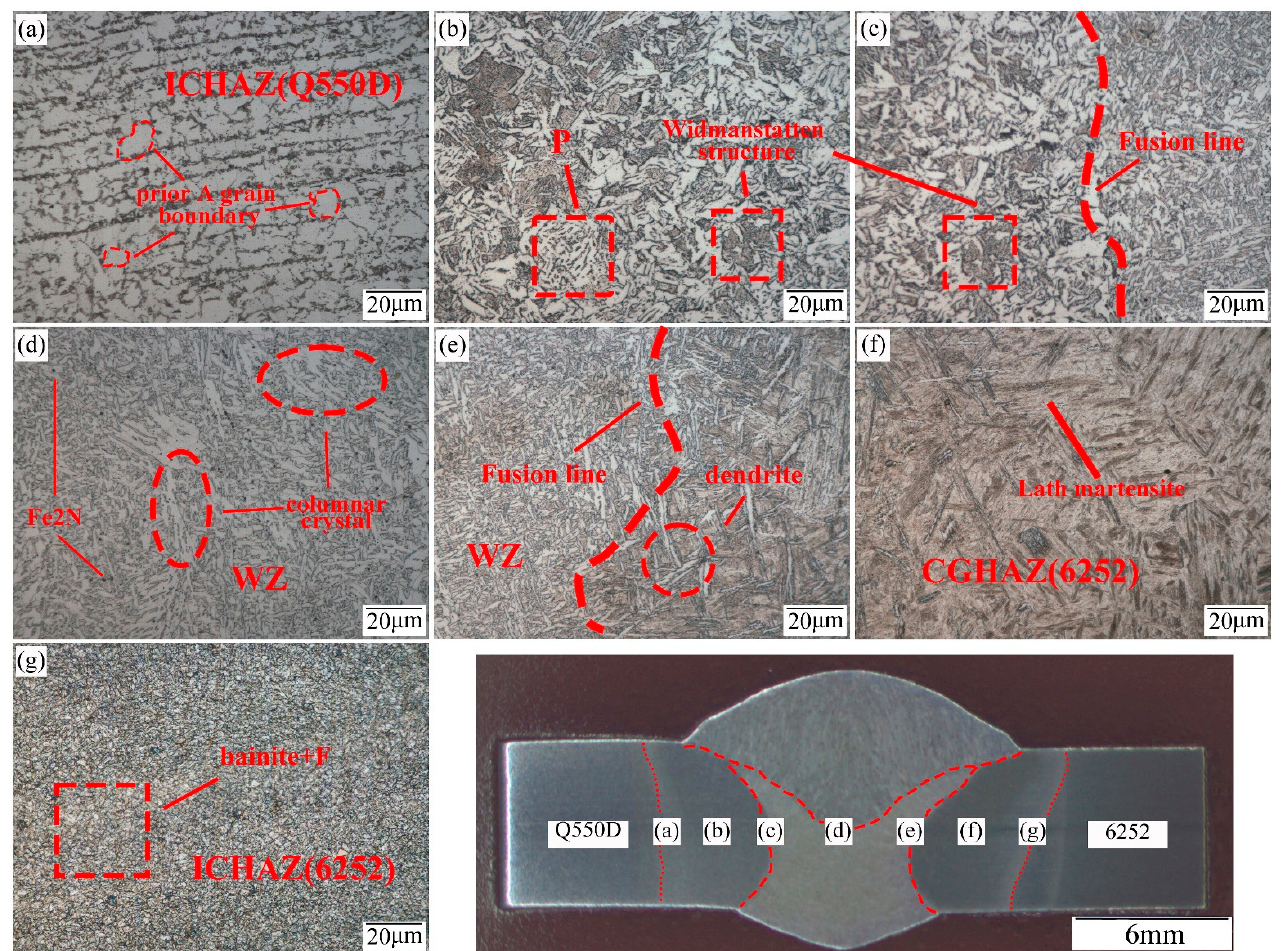
Figure 3. Microstructure of the dissimilar welded joint (ER70S-G): ( a ) intercritical HAZ (Q550D), ( b ) coarse-grained HAZ (Q550D), ( c ) fusion zone (Q550D), ( d ) weld zone, ( e ) fusion zone (6252), ( f ) coarse-grained HAZ (6252), and ( g ) intercritical HAZ (6252).